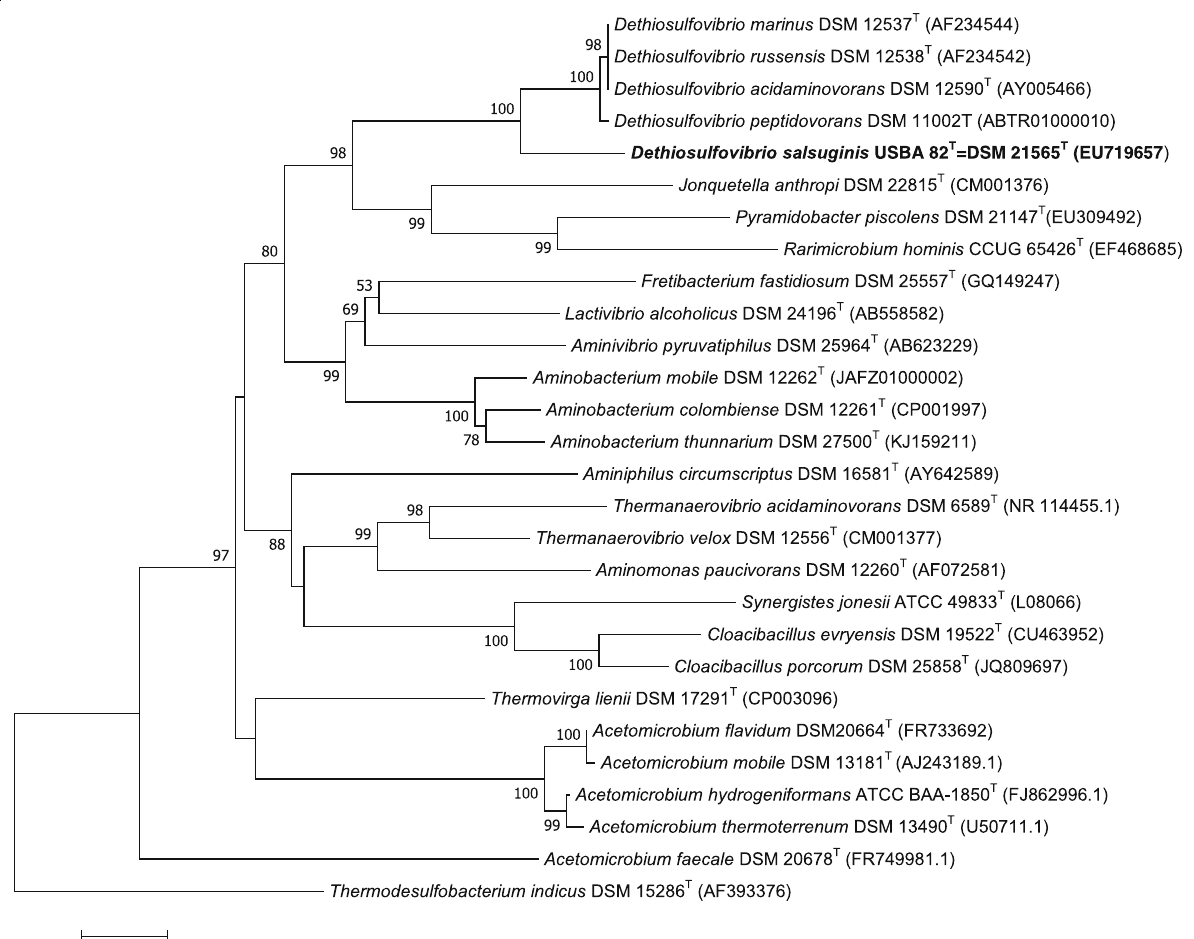
Fig. 2 Relationships of D. salsuginis USBA 82 T using 16S rRNA gene was inferred using the Neighbor-Joining method. The percentage of replicate trees in which the associated taxa clustered together in the bootstrap test (1000 replicates) is shown next to the branches. The evolutionary distances were computed using the Jukes-Cantor method and are in the units of the number of base substitutions per site. The analysis involved 28 nucleotide sequences. All positions containing gaps and missing data were eliminated. There was a total of 1085 positions in the final dataset. Evolutionary analyses were conducted in MEGA7